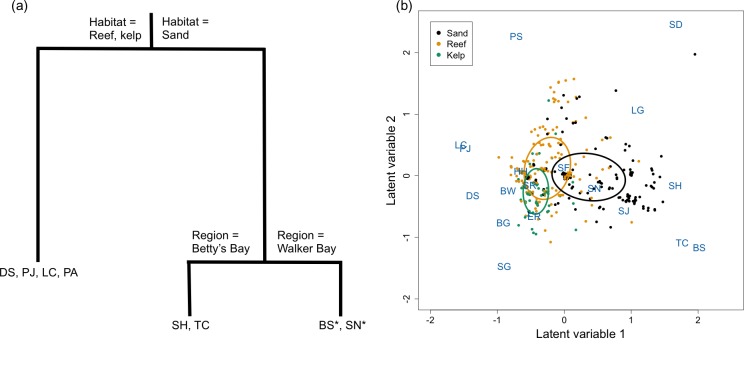
(a) Multivariate regression tree (MRT) and (b) boral latent variable ordination of the observed chondrichthyan community. Points are colour-coded by habitat. The ellipses represent 95% confidence intervals around the mean for sites from each habitat. Two-letter species’ codes (explained in Table 1) (a) represent the species with DLI values > 0.15 (except those marked with *, the most important species for that cluster: DLI0.08–0.12), and (b) are positioned to show the relative values for the coefficient for that species on each latent variable axis.